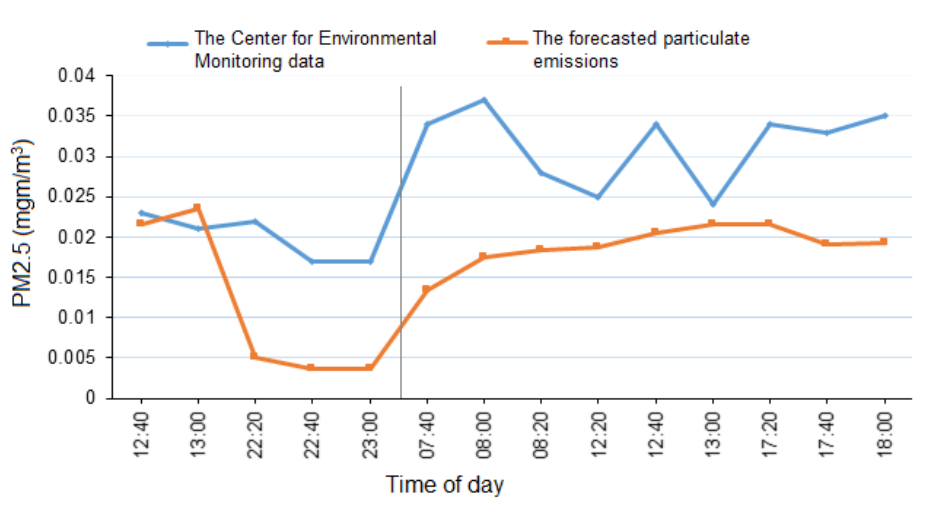
Figure 16. Comparison of the forecasted and actual PM10 emission concentrations. According to a visual comparison of the concentrations, a stable lower value of the predicted emissions of particulate matter indicates the presence of similar emissions from the urban industrial enterprises. These deviations can act as their evaluation measure. The significant unstable deviations observed in the graphs are explained by several random factors in instrumental measurements, such as the single passage of heavy vehi- cles with an unbalanced engine; sharply changing weather conditions; measuring instru- ment error floating in time. These factors cannot be minimized by averaging statistical algorithms due to the complexity and laboriousness of instrumental measurements.